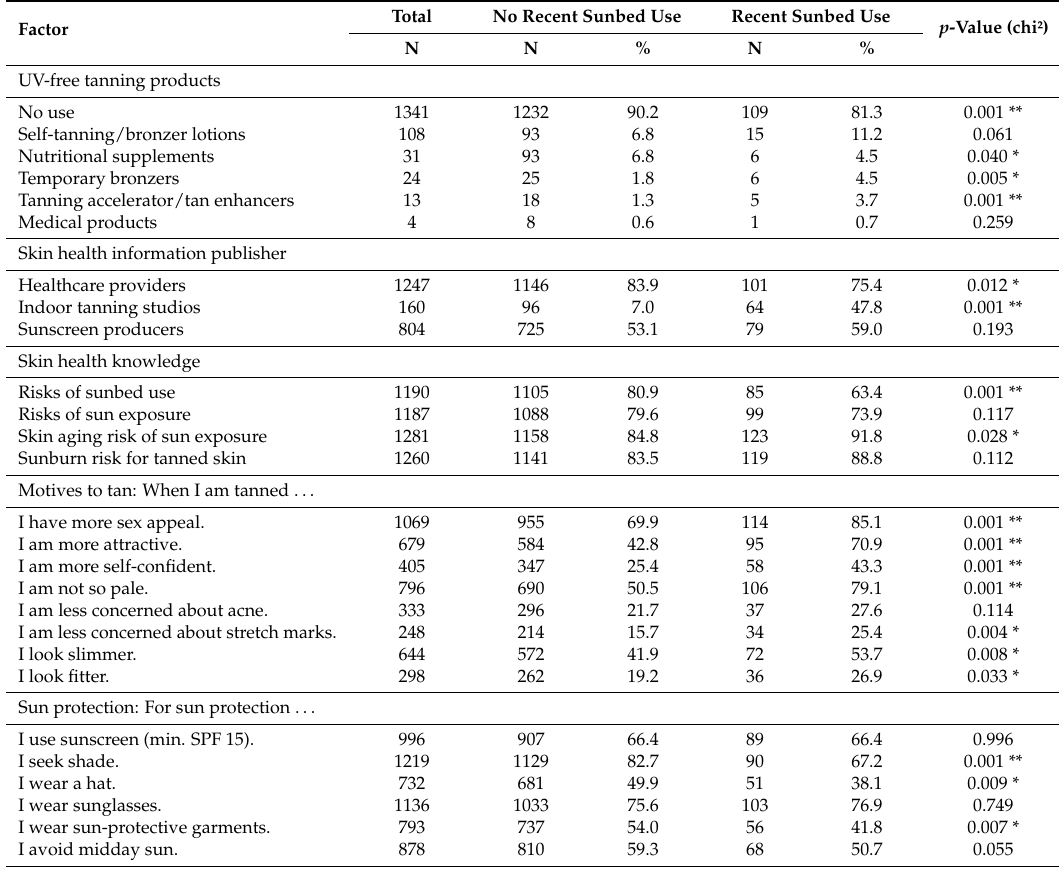
Table 4. Distribution of tanning attitudes, skin health knowledge, and sun protective habits, stratified by sunbed use.